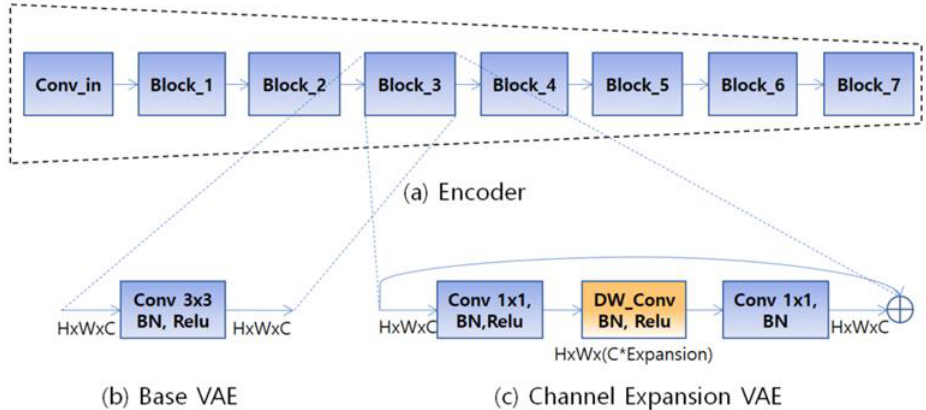
Figure 3. Channel Expansion VAE structure: ( a ) encoder with block unit, ( b ) VAE with convolution, ( c ) VAE with channel expansion. BN is batch normalization and DW_Conv is depth-wise convolution. Table 1. Encoder in channel expansion